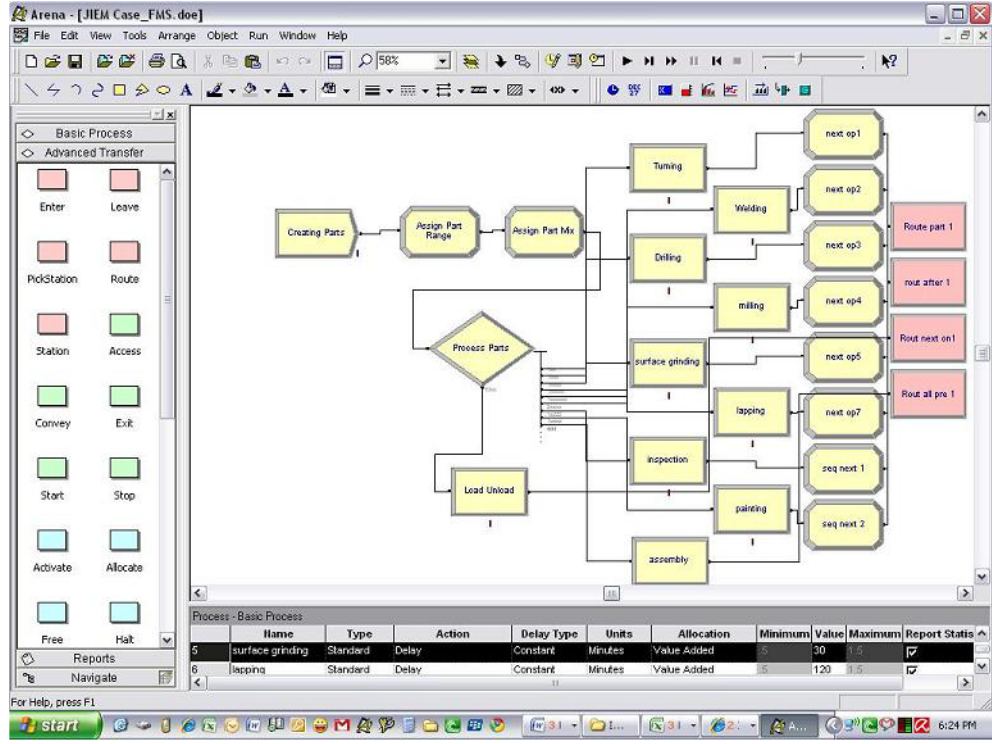
Figure 1. “Arena V.11, Model Snapshot”. Source: Own contribution